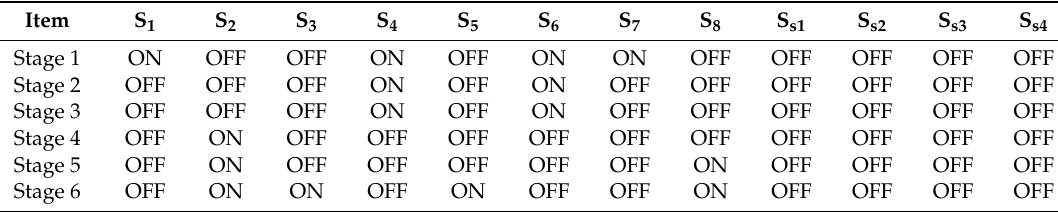
Table 2. Switching scheme in the first half switching period (secondary side modulation